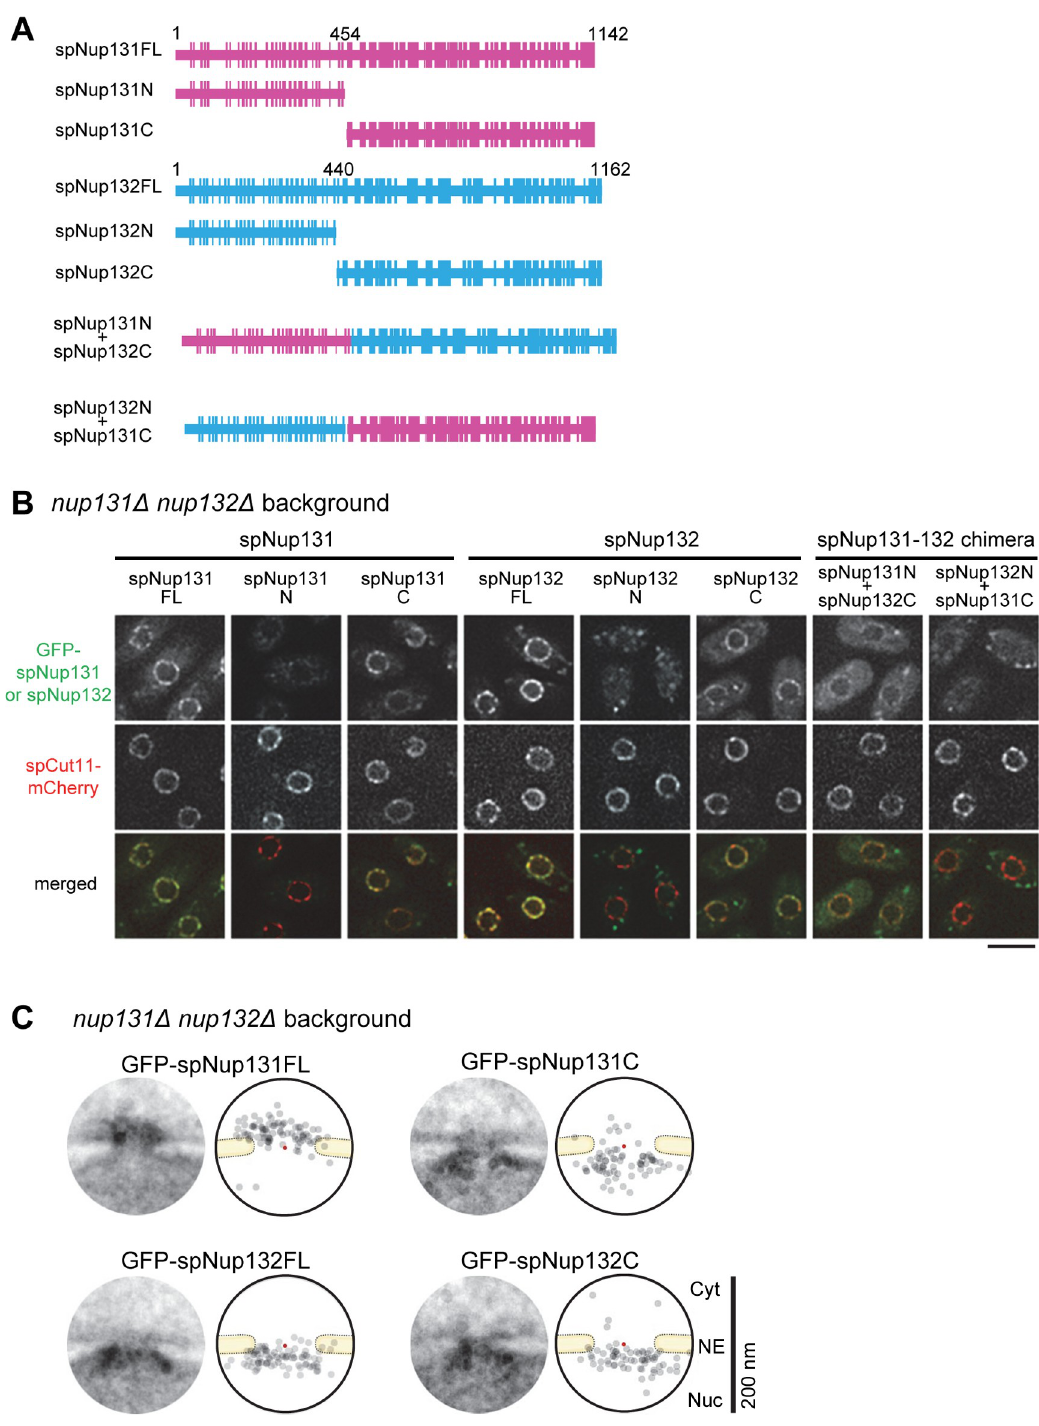
Fig 6. Localization of the spNup131 and spNup132 domains. (A) Schematics of the spNup131 and spNup132 fragments. Magenta represents peptides from spNup131 and light blue represents peptides from spNup132. (B) Localization of spNup131 and spNup132 fragments as determined by FM. GFP-fused fragments were expressed under the spNup132 promoter in the background of the nup131 Δ nup132 Δ double mutant. Cells were grown on YES plate media for only one day. For this short period of incubation, the NPC-clustering phenotype was not apparent. spCut11-mCherry served as an NPC marker. Single section images of the same focal plane are shown. Scale bar, 5 μ m. (C) IEM of the spNup131 and spNup132 fragments. Projection images (left) and immunogold distributions (right) are shown as described in the legend of Fig 1B. The red points indicate the pore centers. IEM micrographs used for the quantitative analysis are available in S10 Dataset.